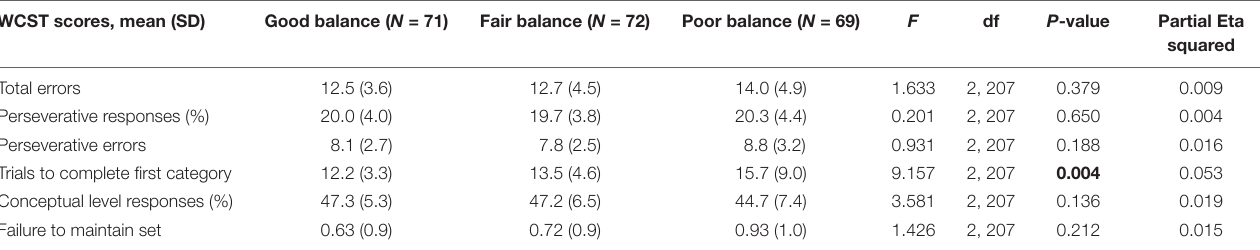
TABLE 3 | Mean and standard deviations of Wisconsin Card Sorting Test (WCST) sub-components. WCST scores, mean (SD) Good balance ( N = 71) Fair balance ( N =